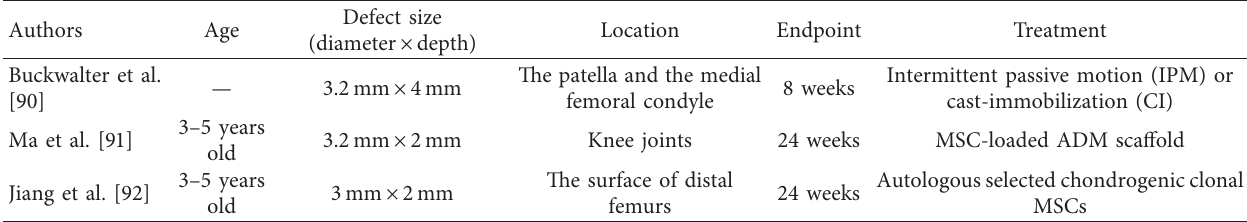
Table 9: Examples of studies using monkey cartilage or osteochondral defect